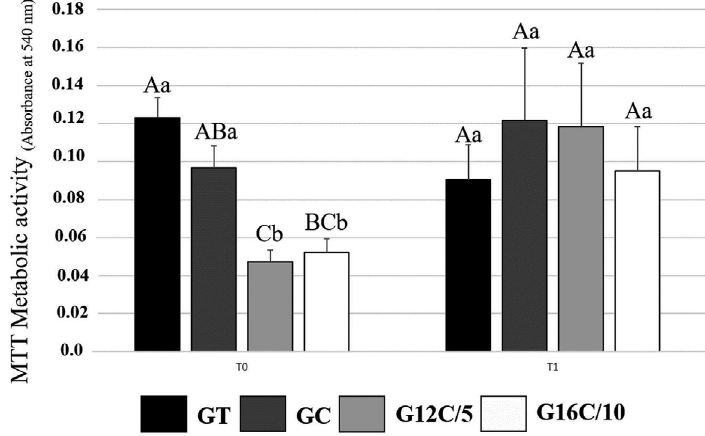
Figure 2- Results of antibacterial activity of the orthodontic adhesive resins. The values of optical density immediately (T0) and after six months of aging in distilled water (T1) are expressed in mean and standard deviation of absorbance values. Different capital letters indicate statistically significant differences among the materials within the same time (p<0.05). Different small letters indicate a statistically significant difference for the same adhesive, comparing the results of different times